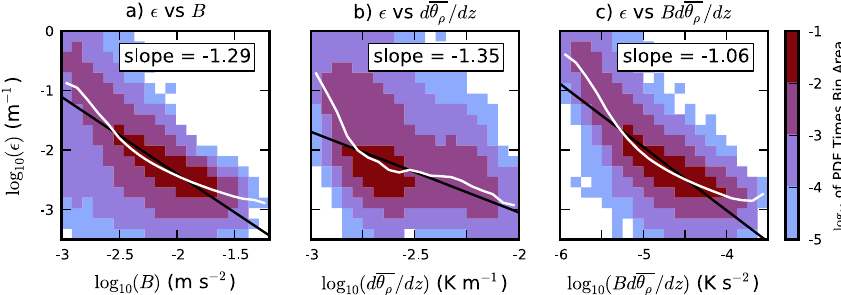
Fig. 11. Joint probability density functions multiplied by bin area ( P(x,y)1x1y ) for individual clouds in the combined BOMEX and ARM LES output of log 10 ((cid:15)) versus (a) log 10 of buoyancy, (b) log 10 of environmental stratification, and (c) log 10 of buoyancy times environmental stratification. PDFs are plotted using a logarithmic scale. White lines indicate the mean log 10 ((cid:15)) value as a function of the x axis variable, and black lines show linear least-square best fits of log 10 ((cid:15)) versus the x axis